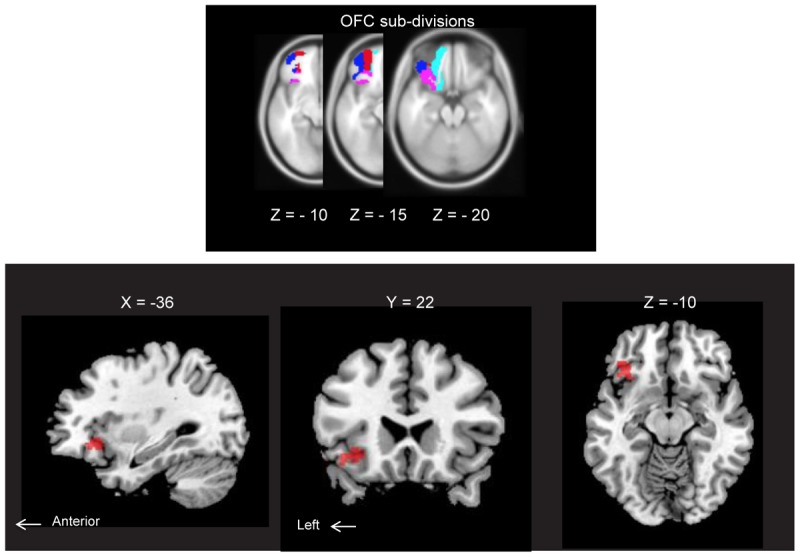
(Upper) Horizontal section of orbitofrontal cortex (OFC) subdivisions: lateral OFC (blue), medial OFC (cyan), anterior OFC (red) and posterior OFC (pink). Each structure was extracted from an image of neuromorphometrics labels in SPM12 (Wellcome Department of Cognitive Neurology, London, United Kingdom) and overlaid on MNI space. All subdivisions are indicated for the left hemisphere only. (Lower) Brain regions showing AM-odor specific responses (the AM-odor > control odor contrast). Results corresponded to FWE corrected P < 0.05 (MNI coordinates: X = –36, Y = 22, Z = –10, T = 3.53, cluster size = 251). These regions also survived at a whole-brain threshold of P < 0.001, uncorrected (cluster extension 10 voxels).